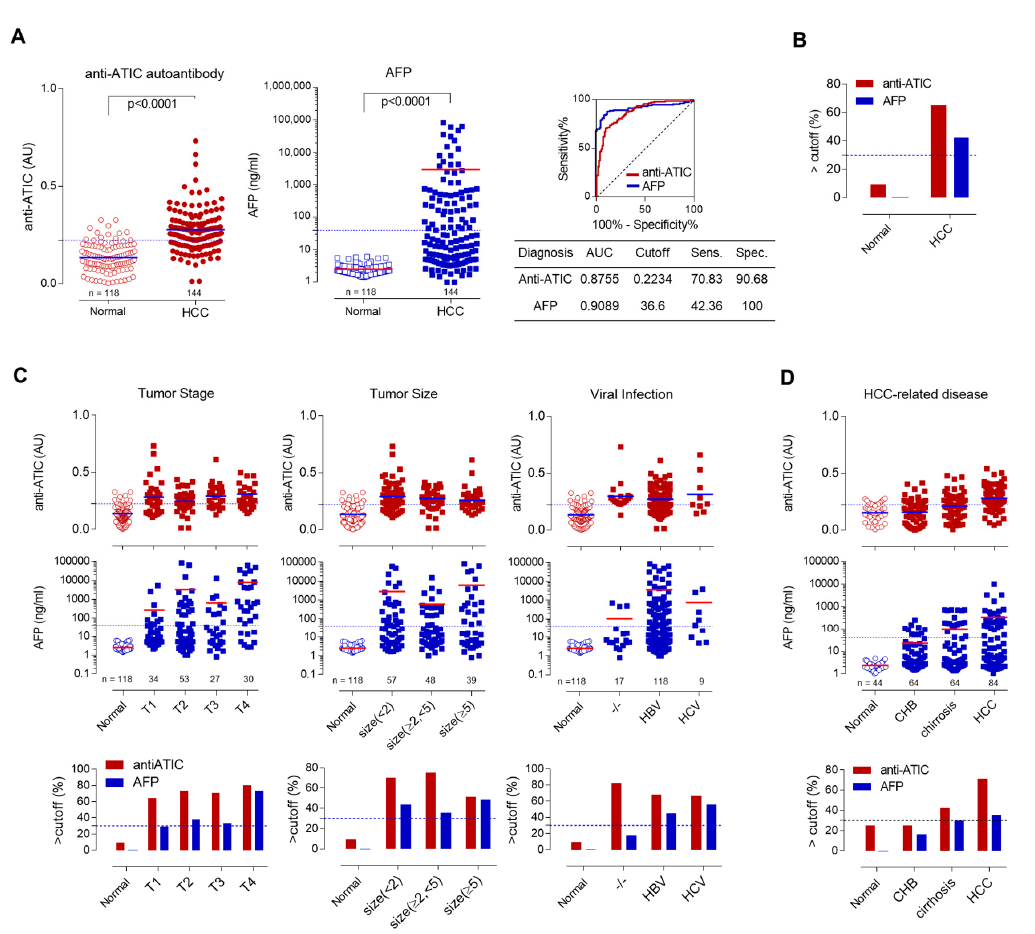
Figure 4. Human serum anti-ATIC ELISA using XC154p1-STA discriminated HCC patients from normal subjects. ( A ) Anti-ATIC autoantibody ELISA using XC154p1-STA in HCC patient’s sera as well as normal subjects. The specific binding of serum autoantibody to XC154p1 epitope (anti-ATIC response) was described as the difference in OD values between XC154p1-STA reaction and that of STA reaction. AFP was measured also for the same cohort. Normal ( n = 118), HCC ( n = 144). ROC curve analysis showed the diagnostic efficiency of each biomarker. All experiments were performed in duplicate and repeated a least three times. ( B ) The percentage of subjects with biomarker response over the cutoff value. ( C ) Anti-ATIC response related to tumor stage, tumor size or viral infection. The top panels show the anti-XC154p1 response of each sample. The lower panels show the percentages of each group over the cutoff value (CV). The level of AFP depending on these factors are also shown. ( D ) Anti-ATIC autoantibody ELISA using XC154p1-STA in cohort 2 consists of normal ( n = 42), chronic hepatitis ( n = 64), cirrhosis ( n = 64) and HCC ( n = 84). AFP levels of this cohort were also compared. The clinicopathological features, including the above results, are described in detail in Table 3.